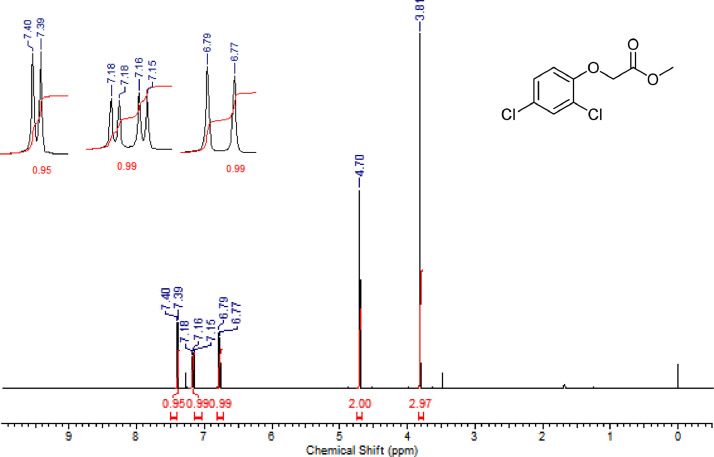
1H NMR (CDCl3, 400 MHz) spectrum of compound 6d